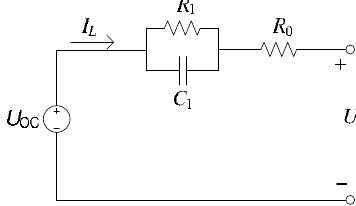
Figure 1. A first-order resistor–capacitor (RC) battery